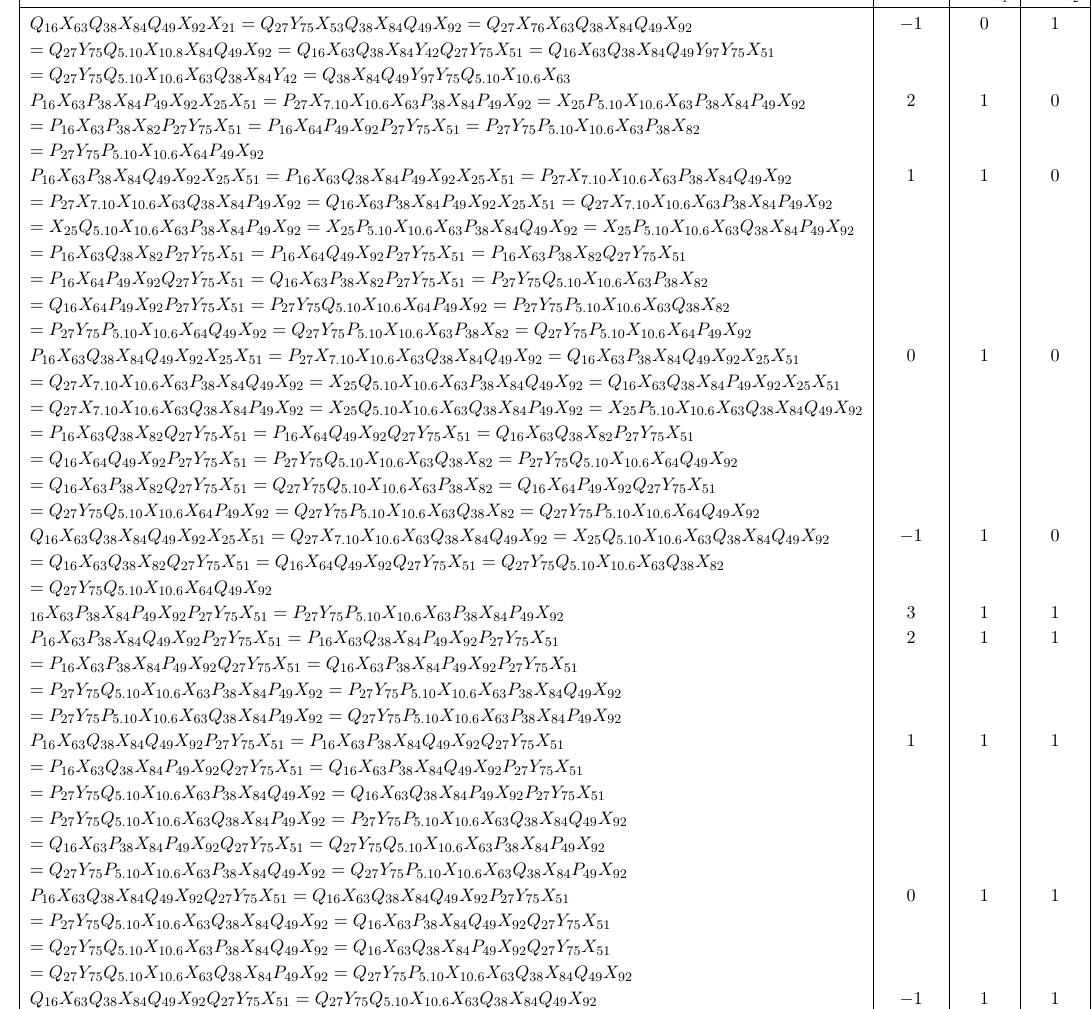
Table 62 . The generators in terms of bifundamental chiral fields for Model 15 (Part 2) .